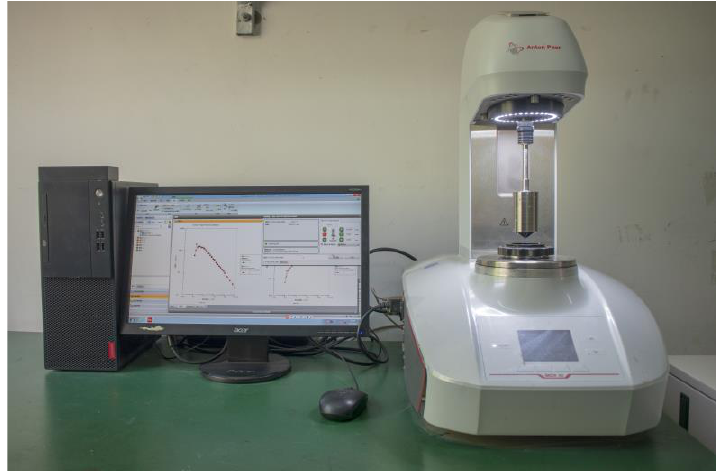
Figure 3. Schematic diagram of an Anton Paar modular compact rheometer (MCR 92).